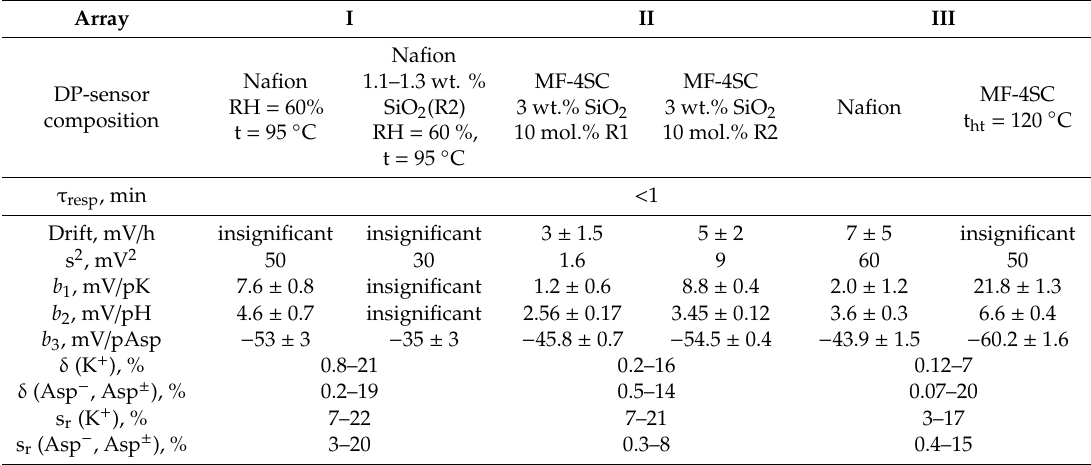
Table 4. Characteristics of DP-sensors arrays for a determination of Asp − , Asp ± , K + ions in the